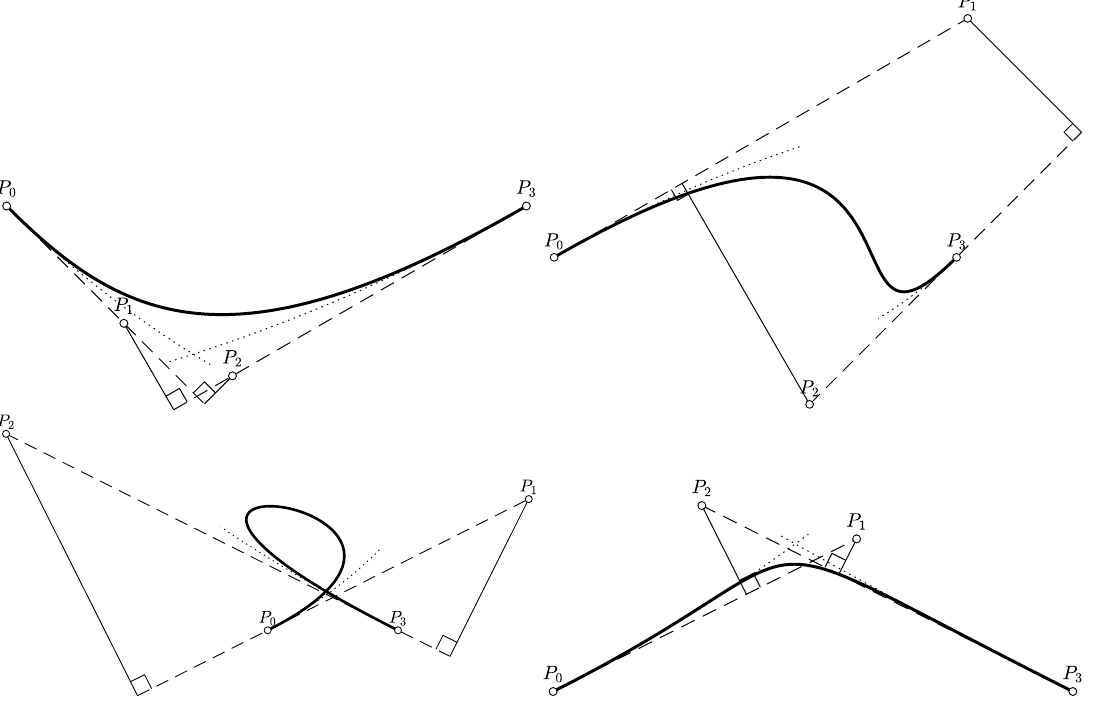
Figure 3. Four basic motion primitives: C-shaped ( top left ), S-shaped ( top right ), loop ( bottom left ), and V-shaped ( bottom right ). The Bézier curves shown with thick line, initial and final orientation with the dashed line, the tangential circular arcs showing the curvature at the endpoints with the dotted